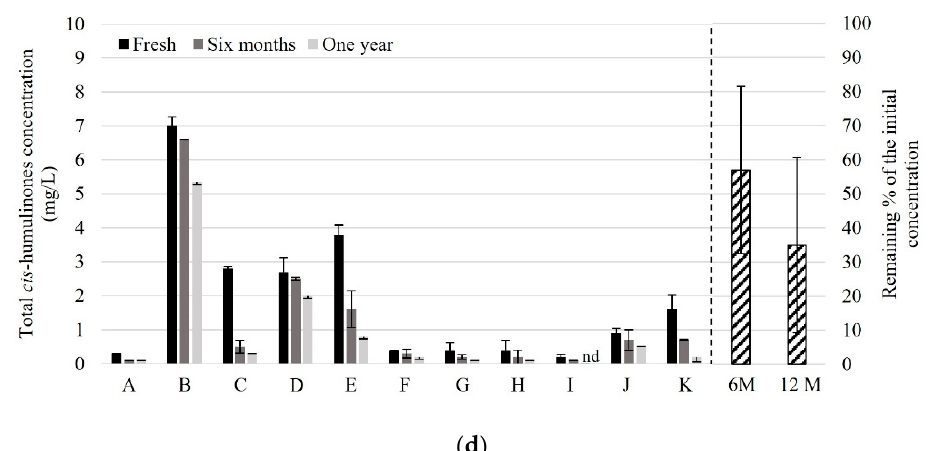
Figure 5. ( a ) Chemical structures of bitter compounds and RP-HPLC-UV chromatograms of fresh and one-year-aged beer K. 1: cis -isohumulones, 2: trans -isohumulones, 3: humulones, 4: cis -humulinones, 5: hulupones, and 6: tetrahydro-isohumulones *. (*: not found in beer K) ( b ) Total cis -isohumulones, ( c ) total trans -isohumulones, and ( d ) total cis -humulinones concentrations (mg/L) in fresh, six-months-aged (6M), and one-year-aged (12M) NABLABs, measured by RP-HPLC-UV and the respective remaining % of their initial concentration.